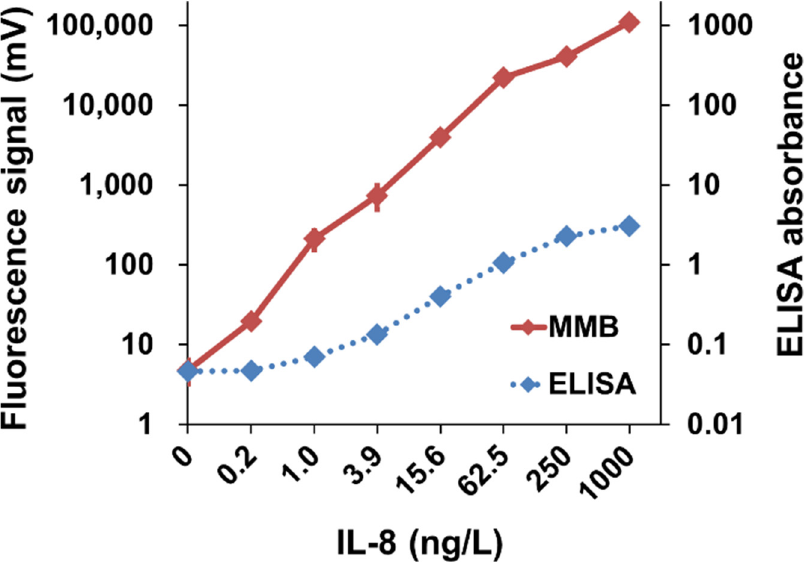
Figure 5. IL-8 dose response. Comparison of IL-8 dose response in 25% plasma with MMB and a standard ELISA kit. Reprinted from [11] , Copyright (2017), with permission from Elsevier.